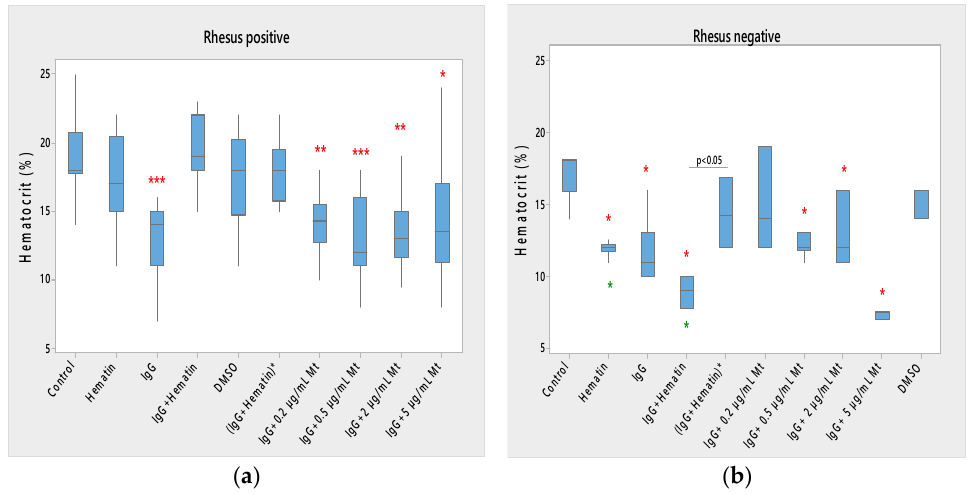
Figure 1. Effect of fixed concentrations of pooled immunoglobulin G (10 mg/mL), hematin (80 µM) and melittin (0.2 µg/mL Mt; 0.5 µg/mL Mt; 2 µg/mL Mt and 5 µg/mL Mt) treatments on hematocrit (average value ± SD) of erythrocytes ( a ) with an Rhesus-positive factor and ( b ) Rhesus-negative factor. The pre-incubated sample of pooled immunoglobulin G (10 mg/mL) with hematin (80 µM) is indicated by an asterisk on the abscissa. Erythrocytes were treated with biomacromolecules for 1 h at 37 °C in phosphate buffered saline (PBS), pH 7.4. Hematocrit determination was performed at 25 °C. Each value is the mean ± SD of three independent preparations with 8–15 repetitions each. *** p < 0.001; ** p < 0.01; * p < 0.05 compared to the untreated control (red asterisks) or DMSO (80 µM)—control (green asterisks).